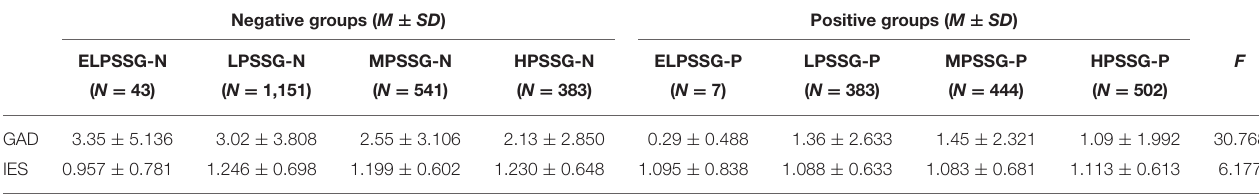
TABLE 4 | Impact of the COVID-19 pandemic and anxiety levels in different latent